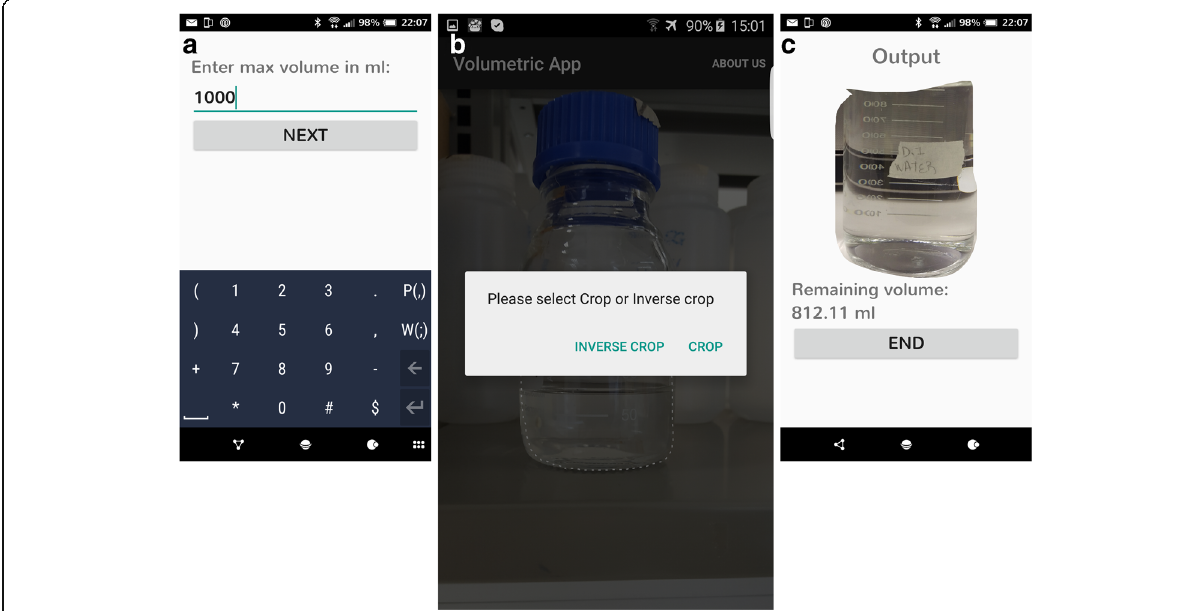
Fig. 2 Determining the Volume. a Entering the maximum volume of the cropped image. b Cropping of the contents. c Results of the calculation of the remaining